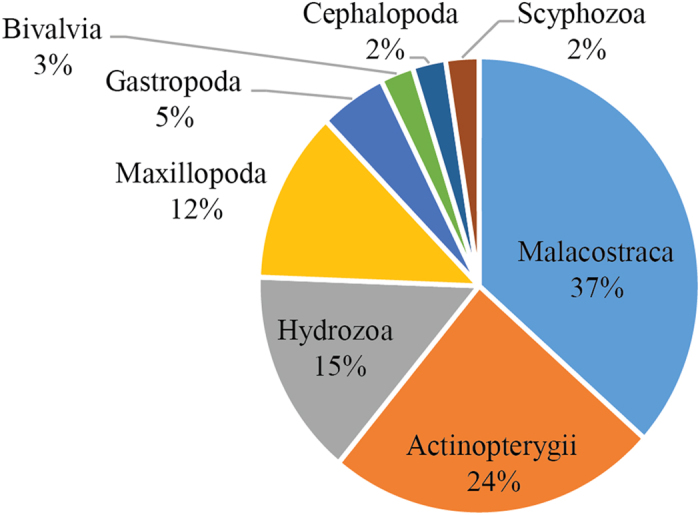
Summary of the prey taxa identified from sunfish consumed items.